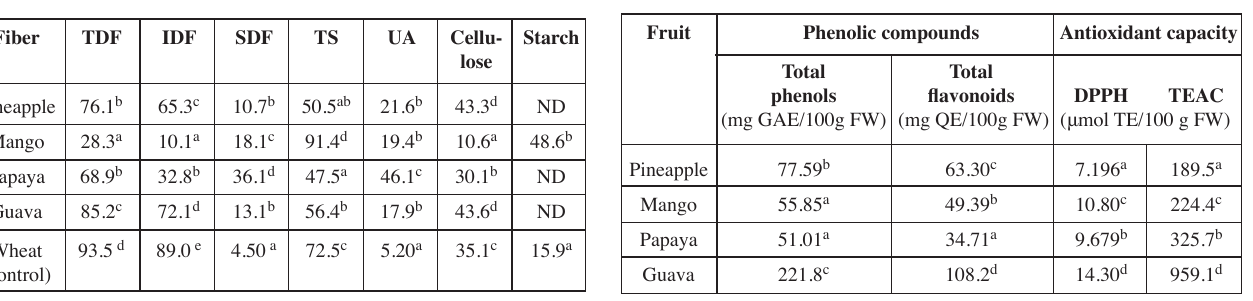
FW: fresh weight. GAE: gallic acid equivalents. QE: quercetin equivalents. TE: trolox equivalents. Means values in each column followed by a different letter are significantly different